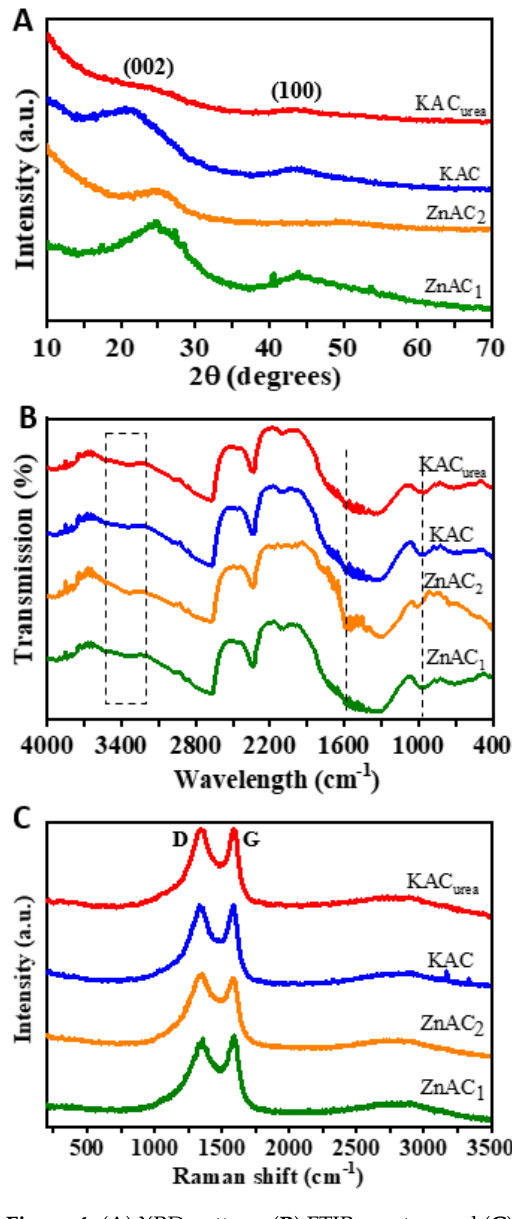
Figure 4. ( A ) XRD pattern, ( B ) FTIR spectra, and ( C ) Raman spectra of GM-derived AC, i.e., KAC urea , KAC, ZnAC 1 , and ZnAC 2 .